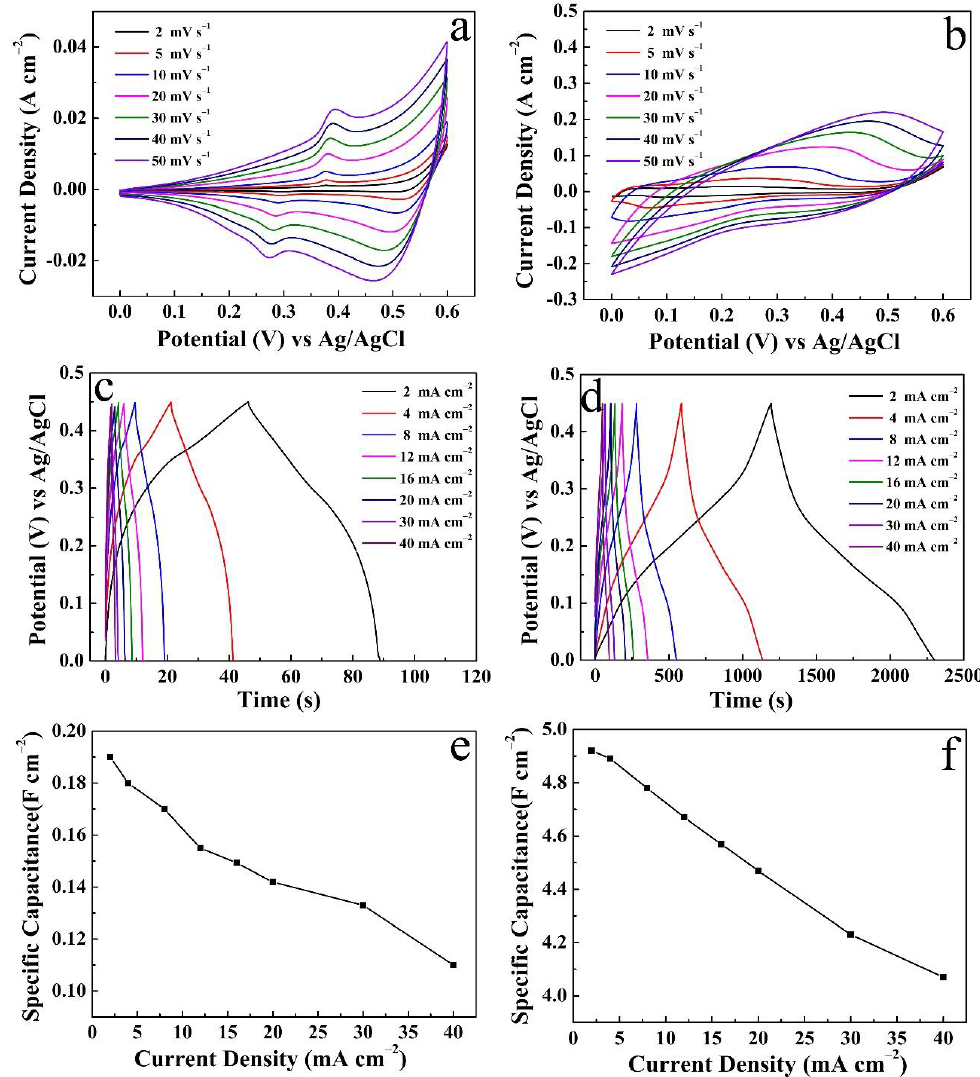
Figure 8. CV curves, GCD curves at different current densities and corresponding C s of Cu(OH) 2 ( a , c , e ) and NCS electrode ( b , d , f ). The Cu(OH) 2 /NCS electrode was further tested for long-term cycling stability in a three-electrode system at 40 mA cm − 2 (Figure 9). The C s reached 92.68% of the original value at 2000 cycles, and still retained 82.93% within 5000 cycles.